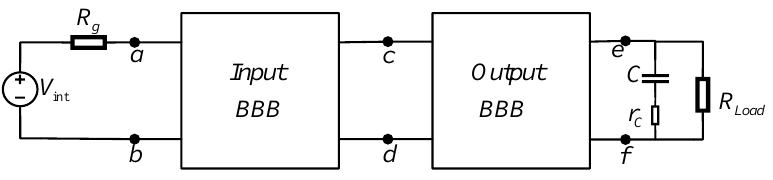
Figure 3. Generalised circuit diagram.